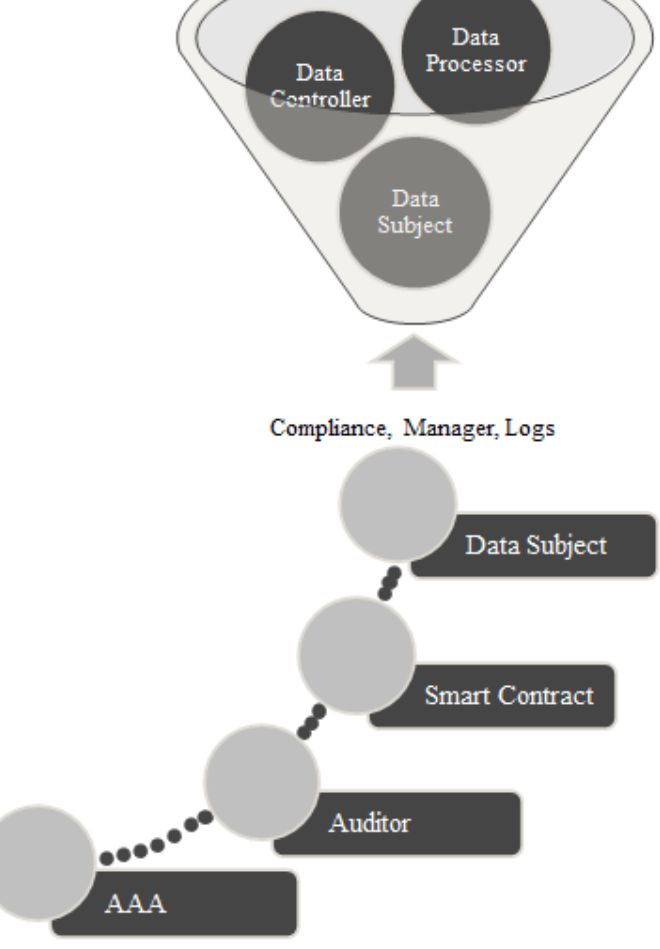
Figure 11. Model for the hysteresis digital signature.